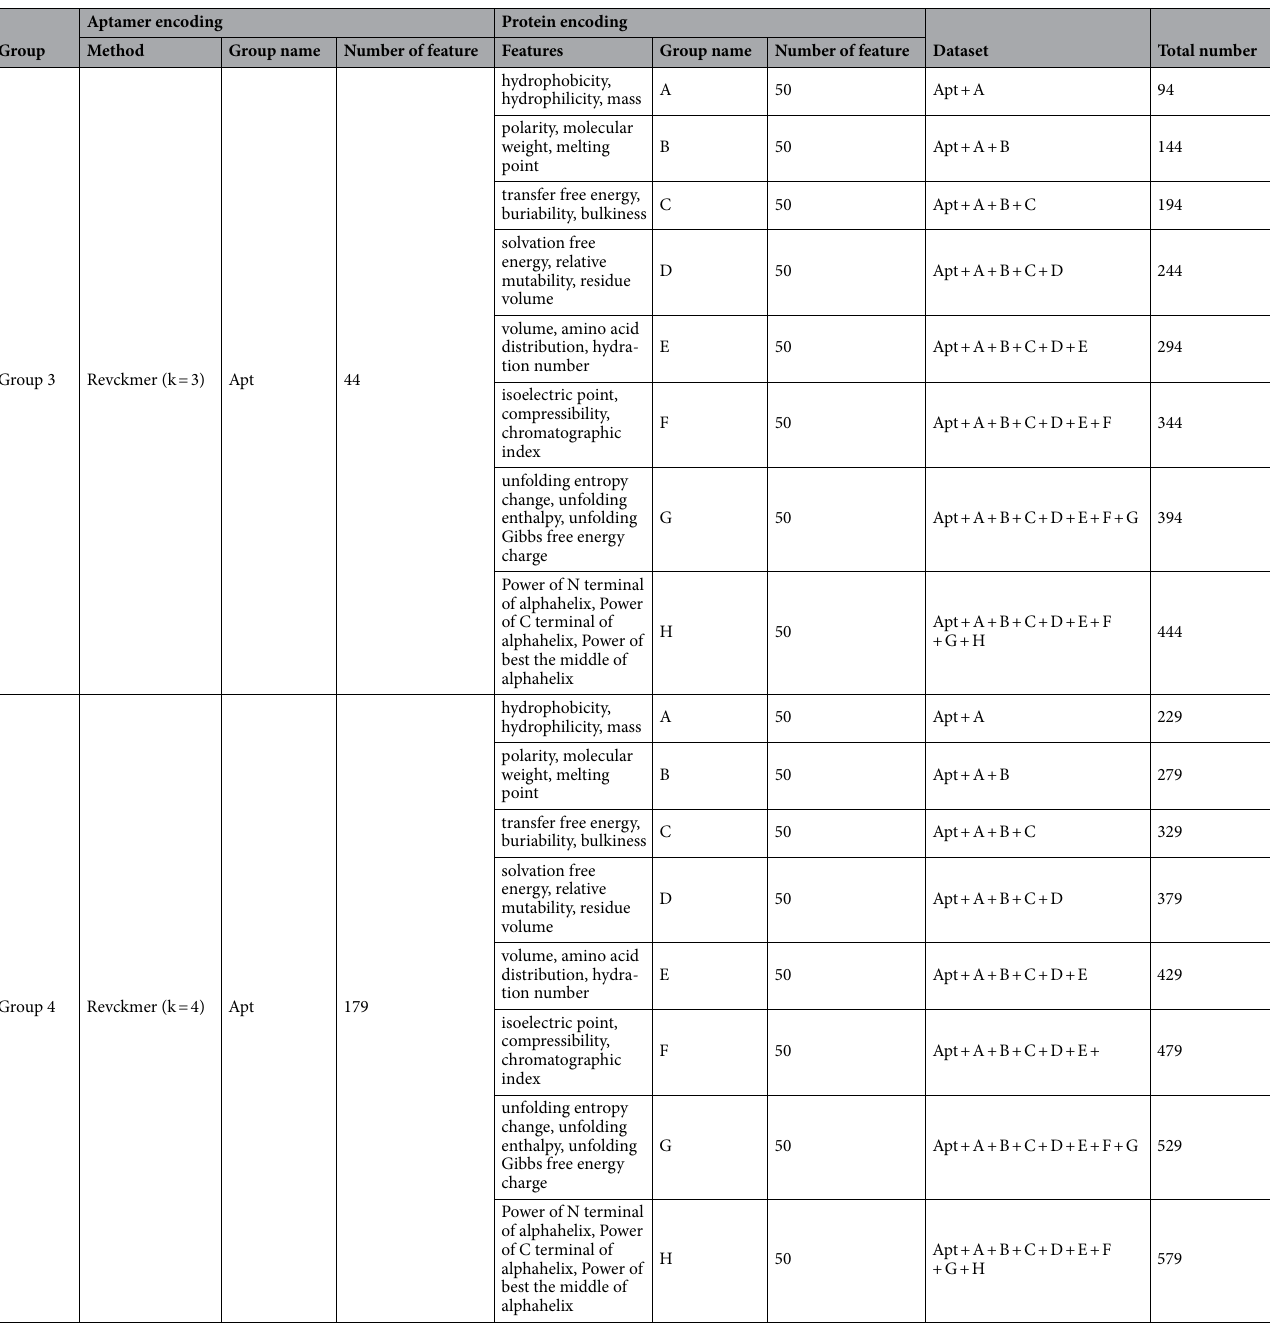
Table 1. Feature group description. Where Kmer (k = 3) is 3mer frequency, Kmer (k = 4) is 4mer frequency, Revckmer (k = 3) is reverse complement 3mer, and Revckmer frequency (k = 4) is reverse complement 4mer frequency for apt, which represents aptamer properties. And, Apt indicates aptamer properties.For protein properties: A indicates hydrophobicity, hydrophilicity, and mass; B indicates polarity, molecular weight, and melting point; C indicates transfer free energy, buriability, and bulkiness; D indicates solvation free energy, relative mutability, and residue volume; E indicates volume, amino acid distribution, and hydration number; F indicates isoelectric point, compressibility, and chromatographic index; G indicates unfolding entropy change, unfolding enthalpy and unfolding Gibbs free energy change; H indicates power to beat the N terminal, C terminal, and middle of the alpha